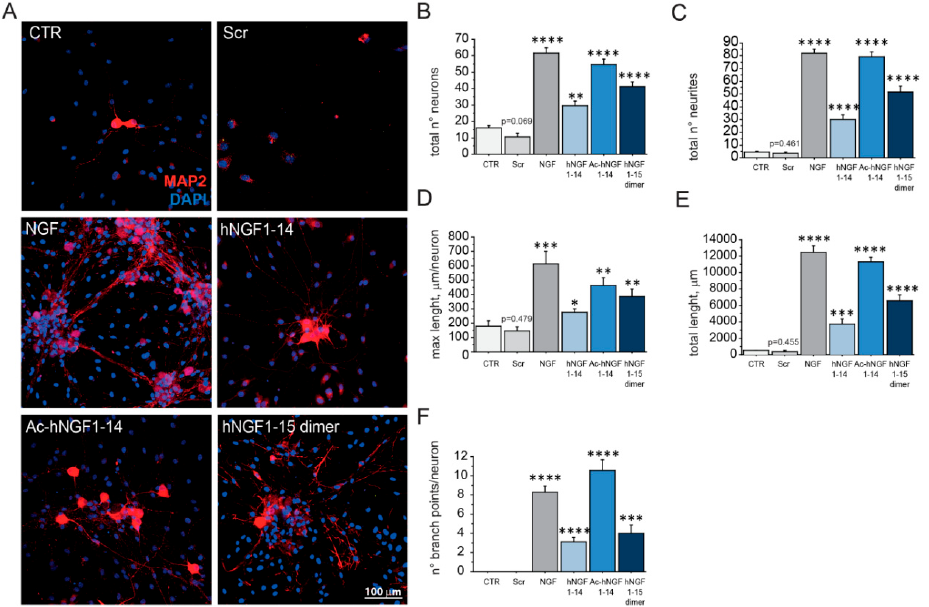
Figure 6. hNGF1–14 peptides sustain survival and neurite elongation of DRG dissociated neurons in absence of NGF. (A-F) Classical DRG assay to test NGF-like bioactivity of hNGF1–14 peptides. ( A ) Dissociated DRG neurons plated and cultured for 5 days in presence of hNGF1–14 peptides (10 μ M) or NGF (100 ng/mL; 3.84 nM). DRG neurons were fixed, immunolabelled with anti-MAP2 antibody for neurites staining, and nuclei were counterstained with DAPI. Images were acquired by means of